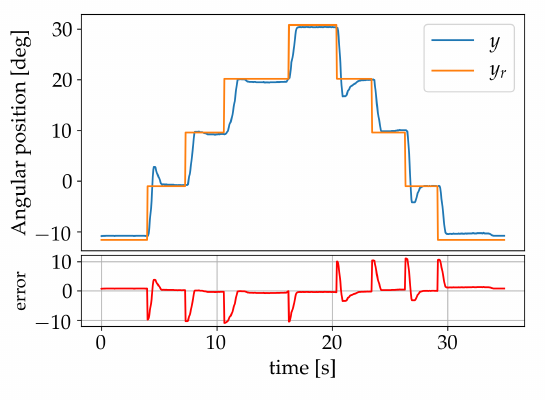
Figure 14. Results after learning.